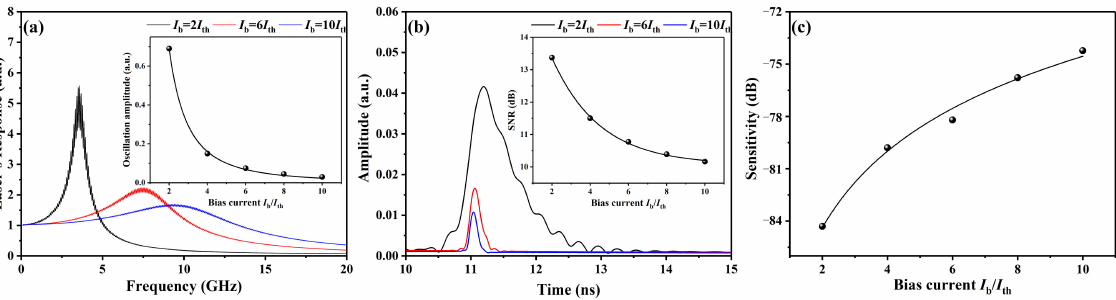
Figure 4. ( a ) Modulation response curve, ( b ) the IFT curves, and ( c ) the sensitivity of frequency resonance method versus laser bias current I b . The insets are the period fluctuation amplitude of modulation response curve and SNR of FDS versus I b ,